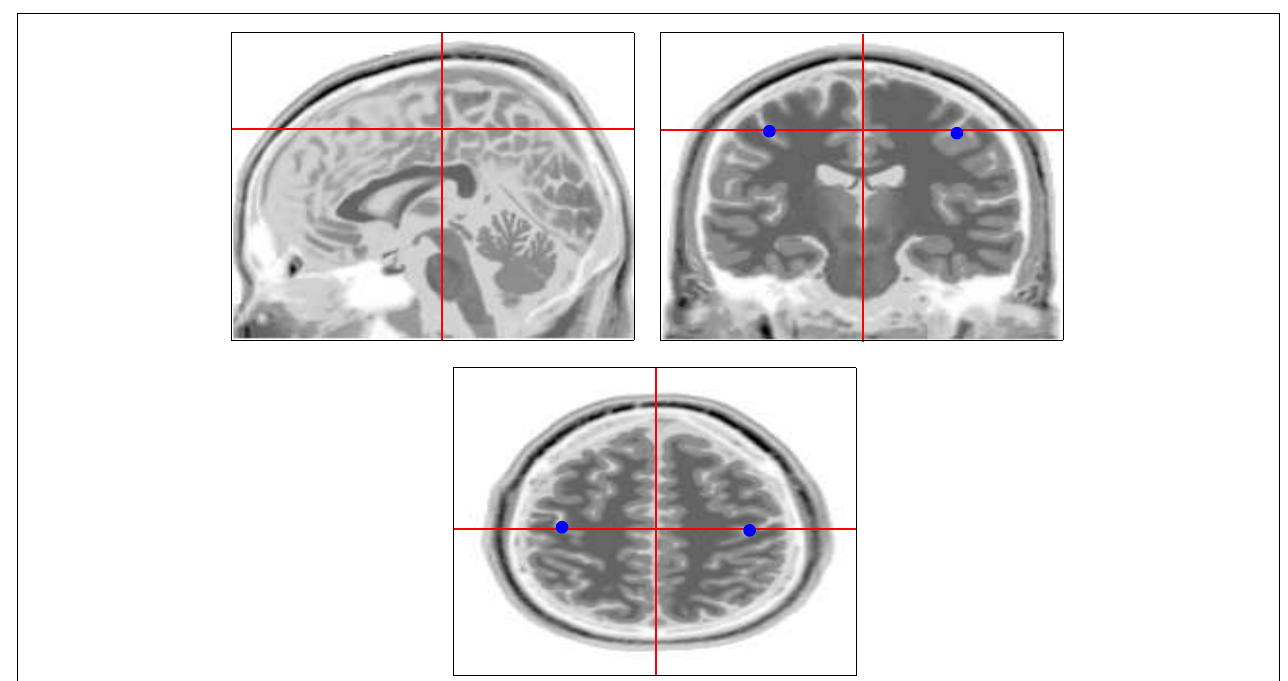
FIGURE 10 | (Data Set 1 – artificial). Location and direction of selected dipoles in the head.